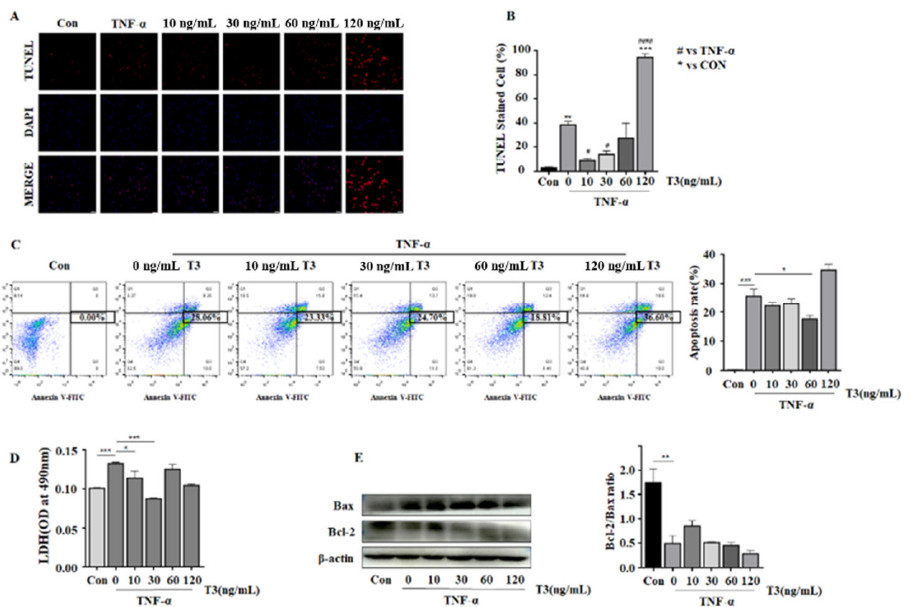
Figure 5. T3 protects neonatal rat cardiomyocytes against TNF- α induced cell apoptosis. ( A ). Staining of TUNEL in cardiomyocytes treated with TNF- α alone or with various concentrations of T3 (10 ng/mL, 30 ng/mL, 60 ng/mL, 120 ng/mL) for 24 h. Red spots indicate TUNEL-positive cardiomyocytes. Scale bar, 50 um. ( B ). Bar chart representing the significant changes in the percentage of TUNEL-stained cells ( n = 3). Data are presented as the mean ± SEM. * p < 0.05 versus control group, # p < 0.05 versus TNF- α group evaluated by one-way analysis. ** p < 0.01, *** p < 0.005, # p < 0.05, ### p < 0.005. ( C ). Flow cytometry analysis of apoptosis by Annexin V-FITC/PI